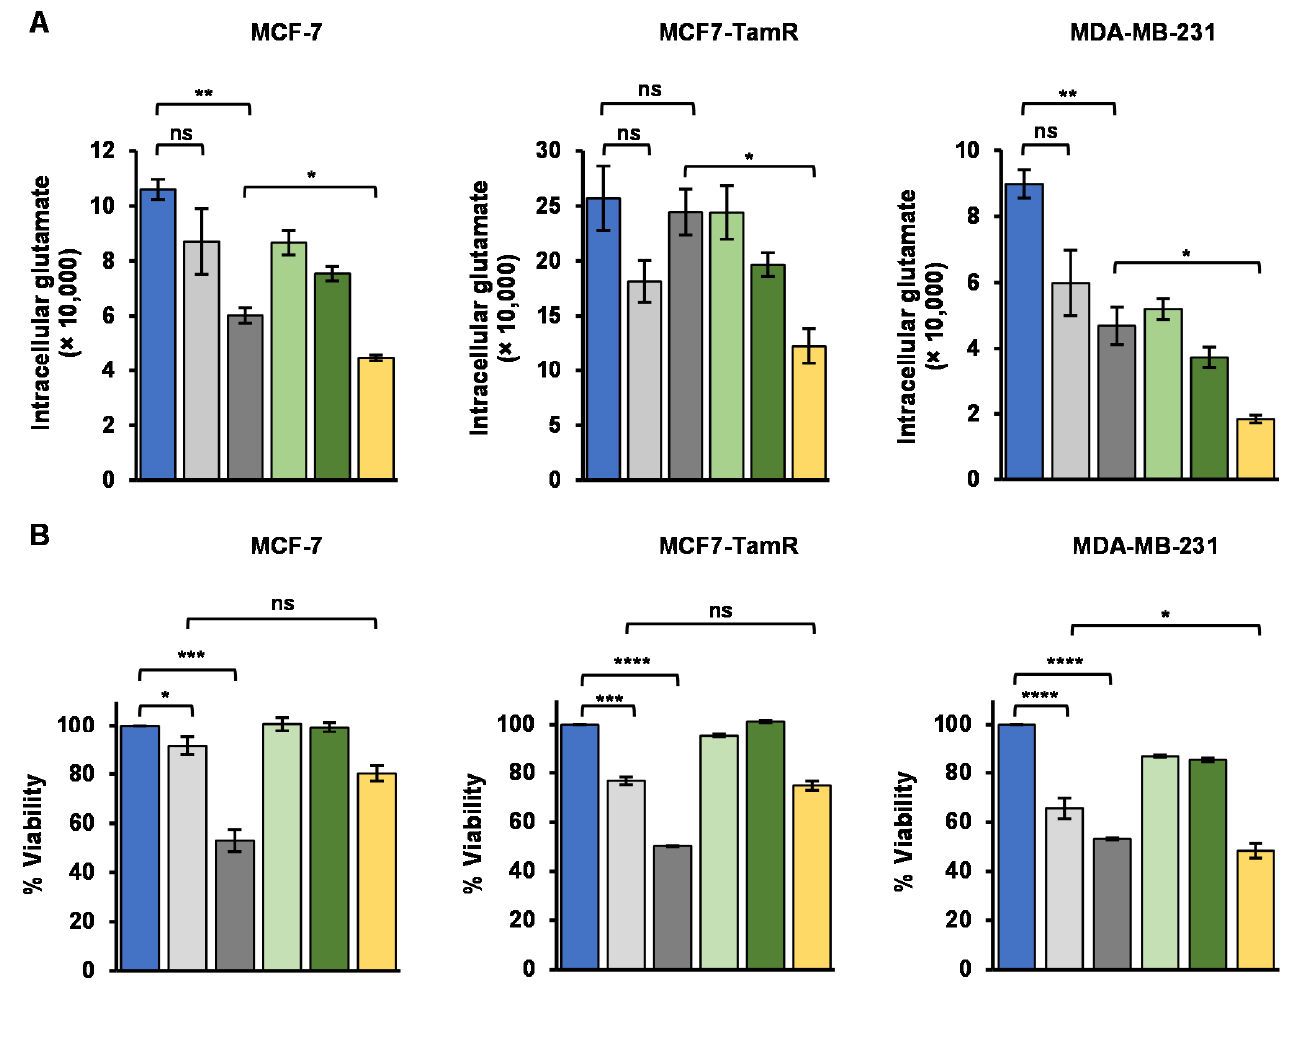
Figure 4. Treatments with 1E5 downregulate the intracellular glutamate levels. ( A ) intracellular glutamate levels were determined by detecting levels of luminescence produced upon the treatments with DMSO, 1E5 (5 µ M), 1E5 (10 µ M), BPTES (5 µ M), BPTES (10 µ M) and 1E5 (5 µ M) + BPTES (5 µ M for 48 h. Luminescence signals were normalized to cell numbers from MTT data. ( B ) MTT assay data used here to detect different levels of cell proliferation with the same set of treatments. All the data represented here consist of biological triplicates ( n = 3). Standard errors are shown on the bar graphs. Statistical significance was determined by Student’s t -test (two-tail, two-sample equal variance), where * p < 0.05, ** p < 0.01, *** p < 0.001, **** p < 0.0001 and not significant (ns) p > 0.05.